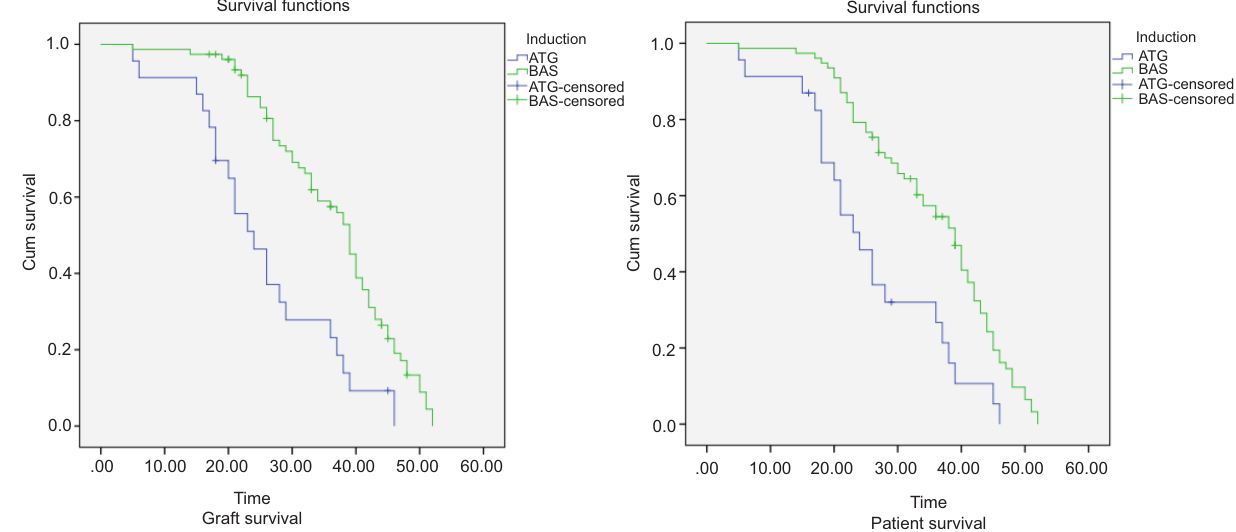
Figure 2: Patient and graft survival curve using the Kaplan–Meier method (P <